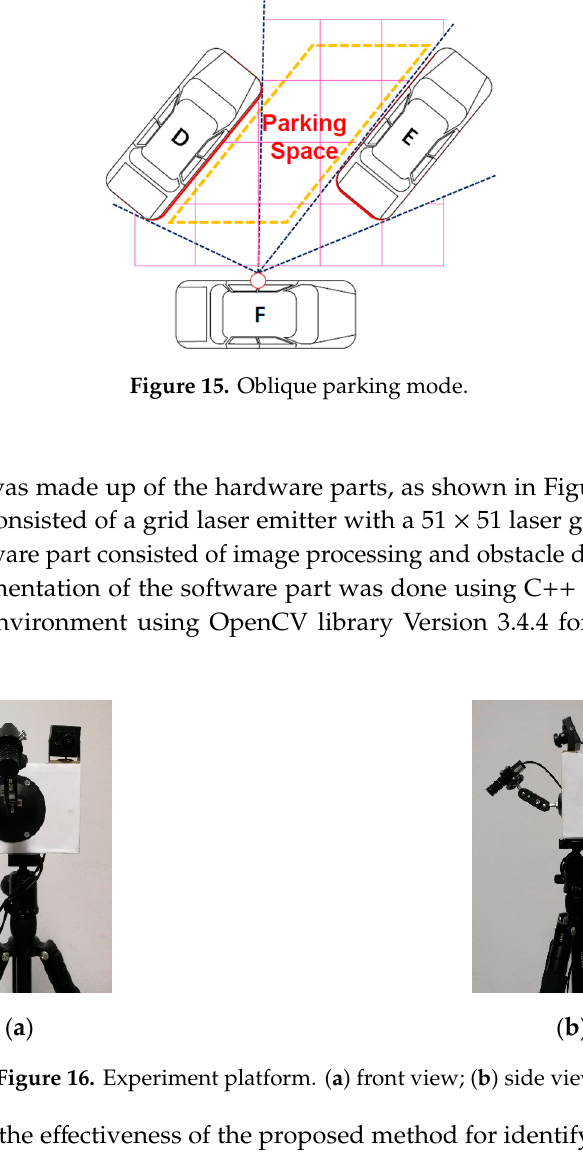
Figure 14. Vertical parking mode.